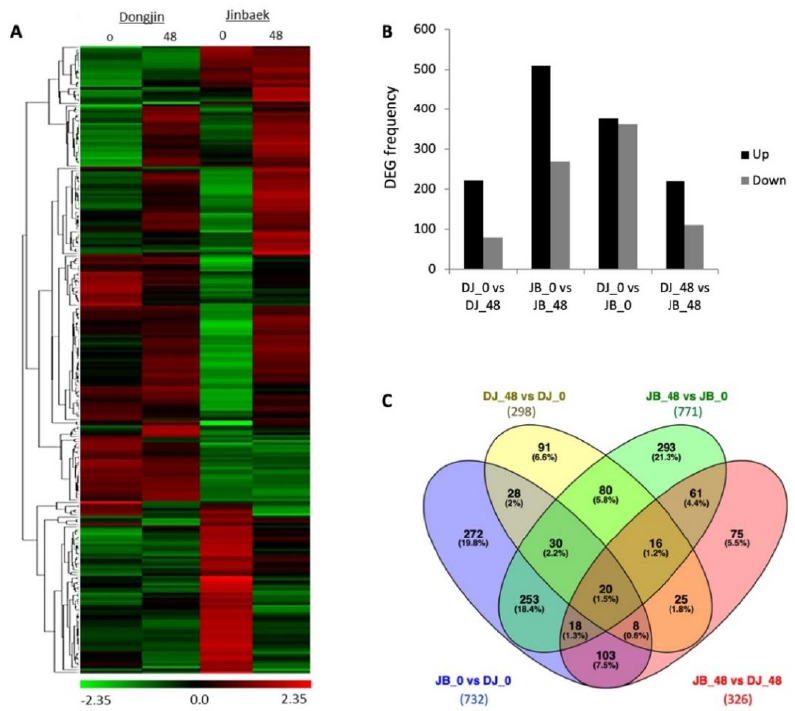
Figure 2. Workflow involved in cDNA microarray data analysis.